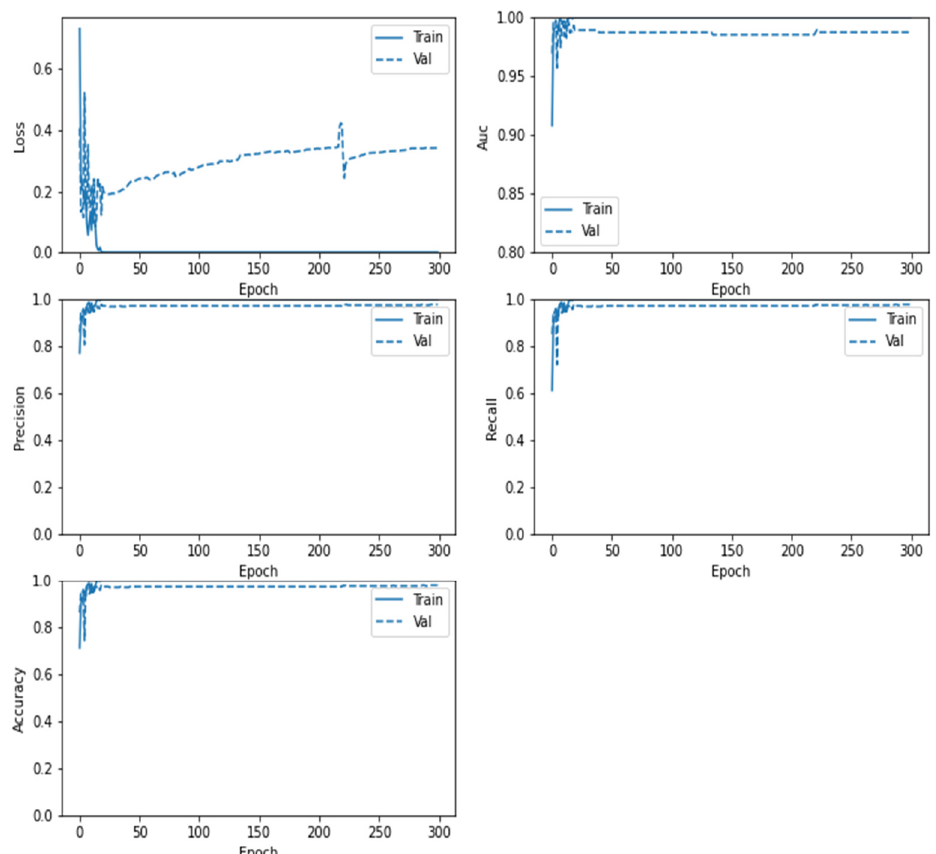
Figure 9. Loss, AUC, precision, recall, and accuracy between the training and validation phases with the number of epochs for the CNN model using DCGAN image generated.